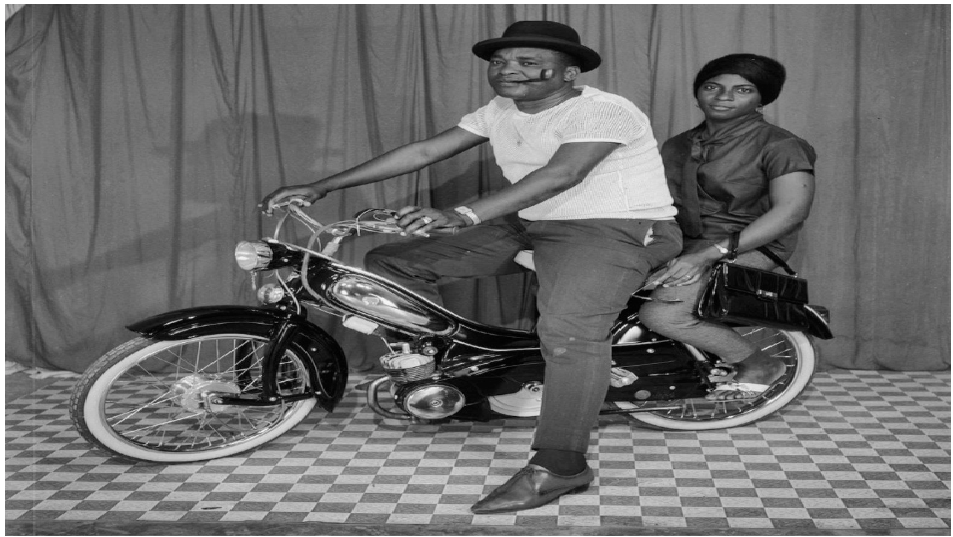
Figure 5. Michael and Juliana in Victoria in 1956.